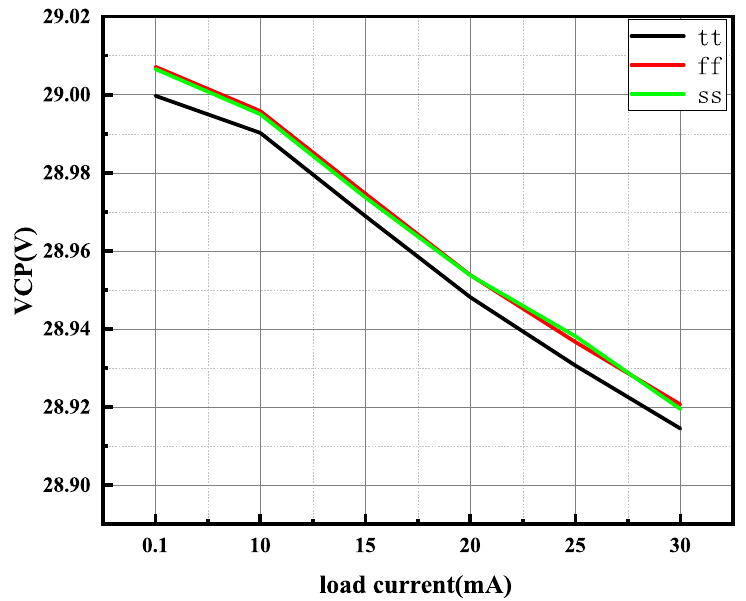
Figure 14. Simulation results of the output signal when the supply voltage changes.